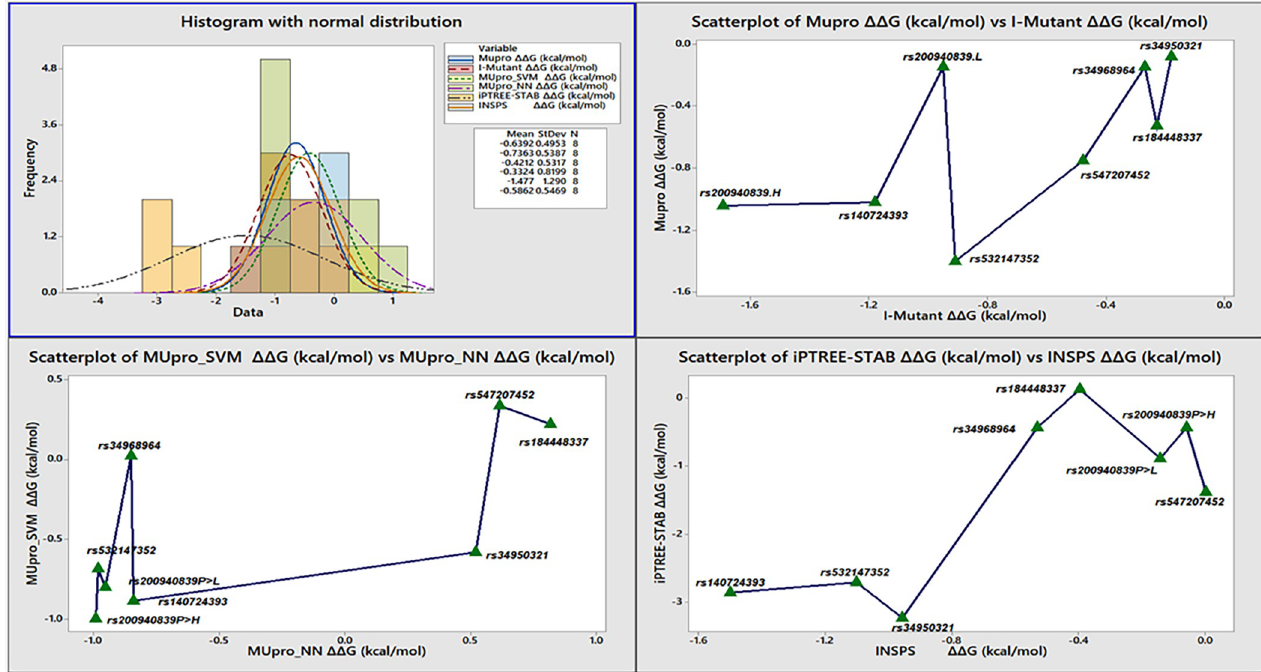
Fig 5. Histogram and scatterplot of rare nsSNPs of PTB-related gene mutations in comparison with functional impact analyses. The top-left section describes the mean and standard deviation values of various in-silico algorithms used to calculate the impact of mutations on protein stability using a normal distribution pattern. The remaining sections compared scatterplots between in-silico algorithms to determine how pathogenic nsSNPs in PTB-related genes affect protein stability.